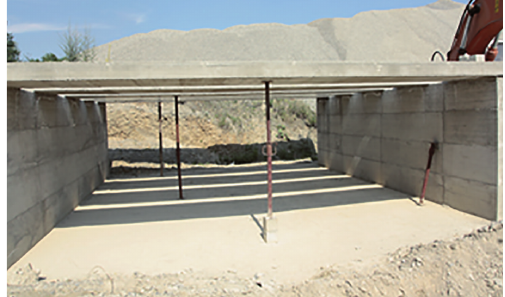
Figure 10: Solid r.c. slabs for testing stress fields with strong